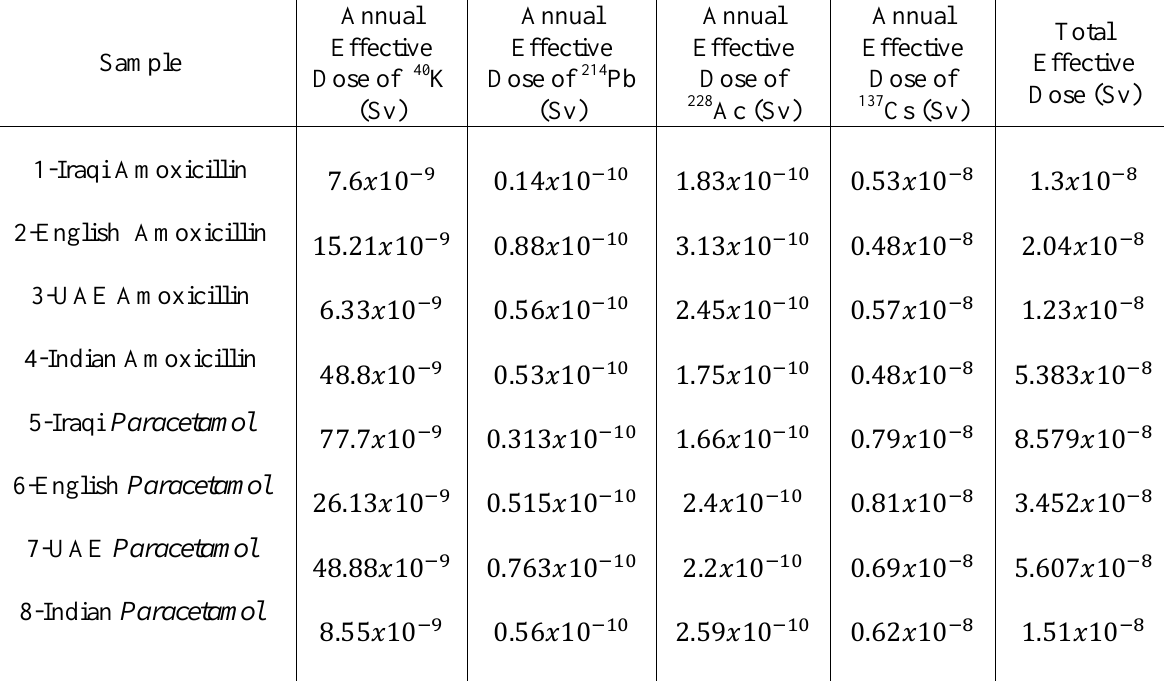
Table 6: The annual effective dose values of each isotope and their sum for all samples.